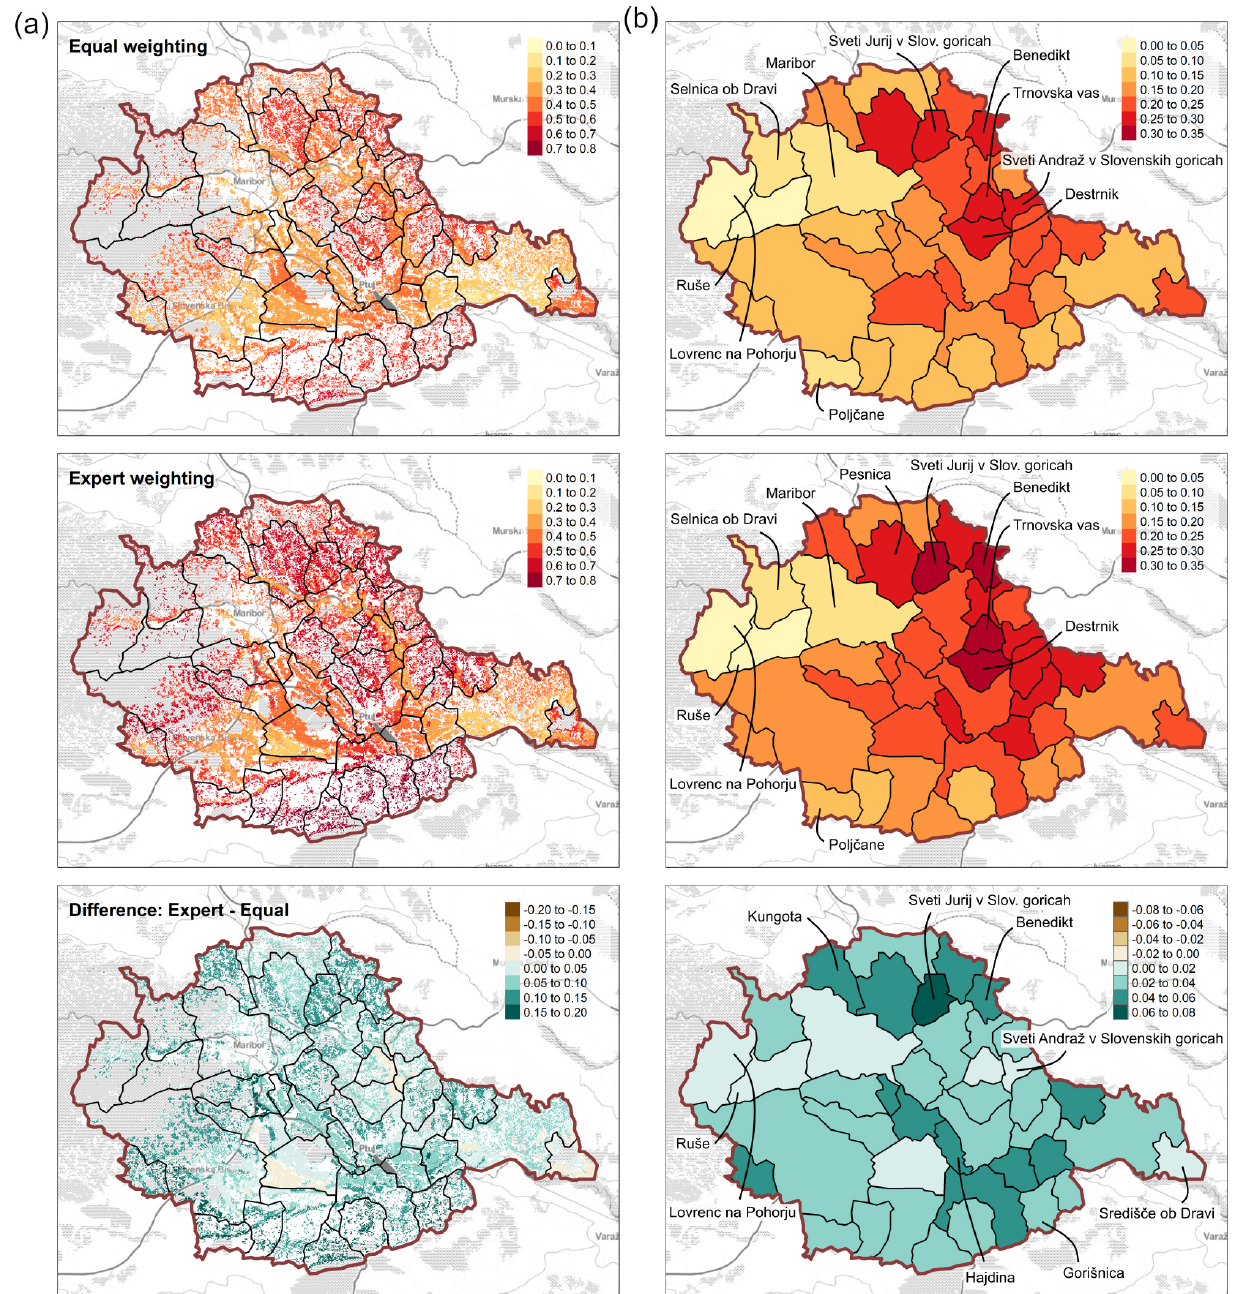
Figure 7. The mapped results of equal weighting, expert weighting methods, and their difference across Podravska. On the left (a) , masked with agricultural used land and before aggregation on LAU2 regions (black borders). On the right (b) , after aggregation for each LAU2 region. LAU2 regions are labelled when showing relatively high or low vulnerability, or relevant differences between the weighting methods.